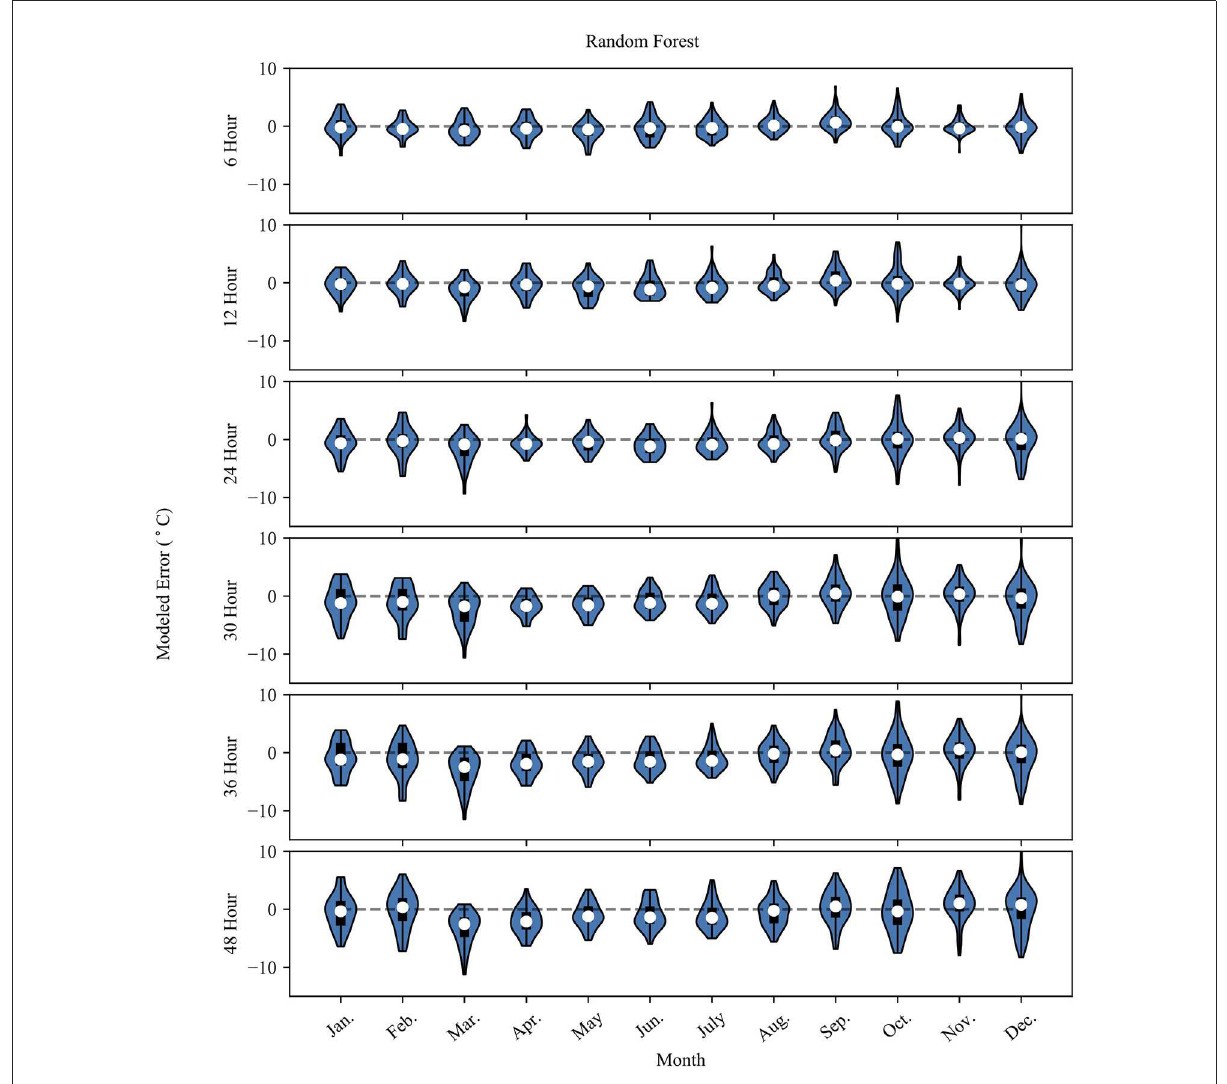
FIGURE5 Same as Figure 4 but for the RF model